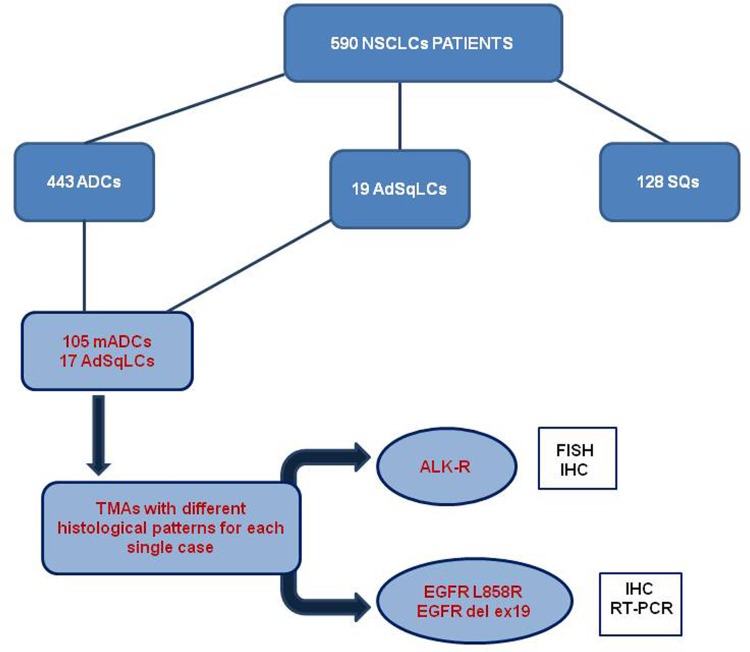
Study Profile.NSCLC: Non Small Cell Lung Cancer; ADC:Adenocarcinoma; AdSqLC: Adenosquamous Lung carcinoma; SQ: Squamous Cell carcinoma; mADCs: mixed adenocarcinomas; ALK-R: ALK-rearrangments.